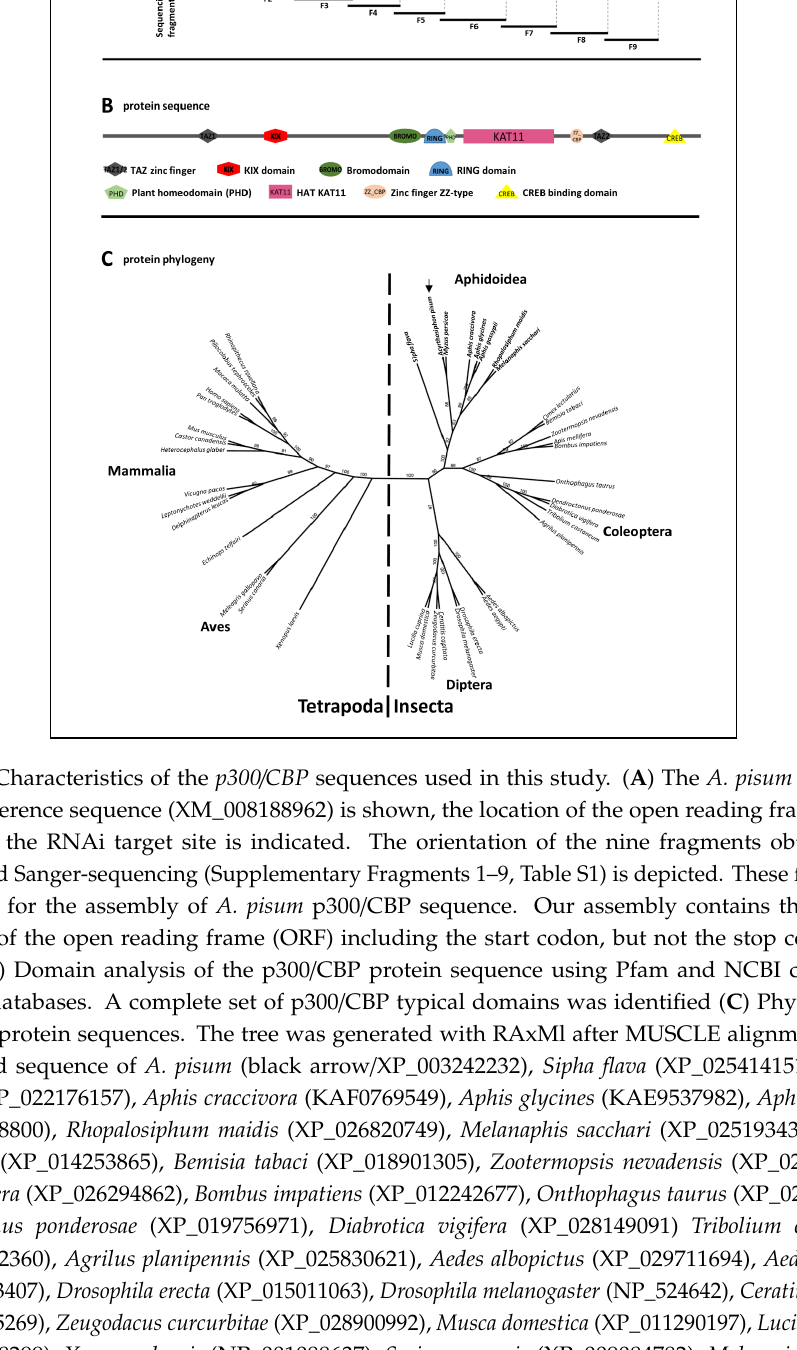
and bootstrap values are shown within the